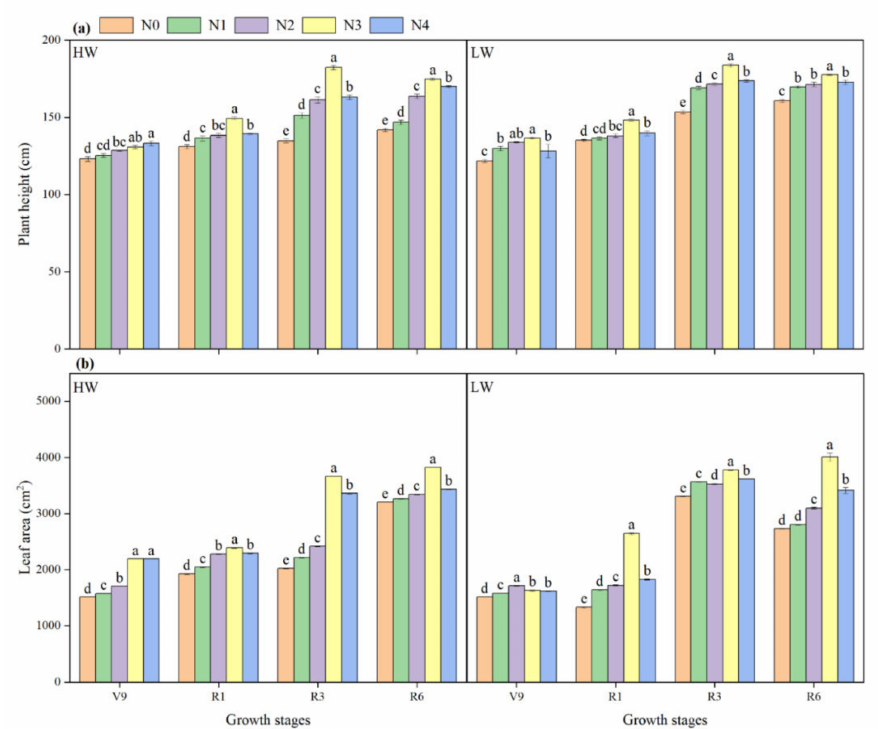
Figure 2. Effects of irrigation and nitrogen rates on plant height ( a ) and leaf area ( b ). HW and LW represent irrigation water at the rate of 80 and 60% of field capacity. Means followed by different lowercase letters within each treatment indicate significant differences ( p < 0.05). Bars represents standard errors. The nitrogen treatments N0, N1, N2, N3 and N4 represent the application of nitrogen at the rates of 0, 200, 250, 300 and 350 kg ha − 1